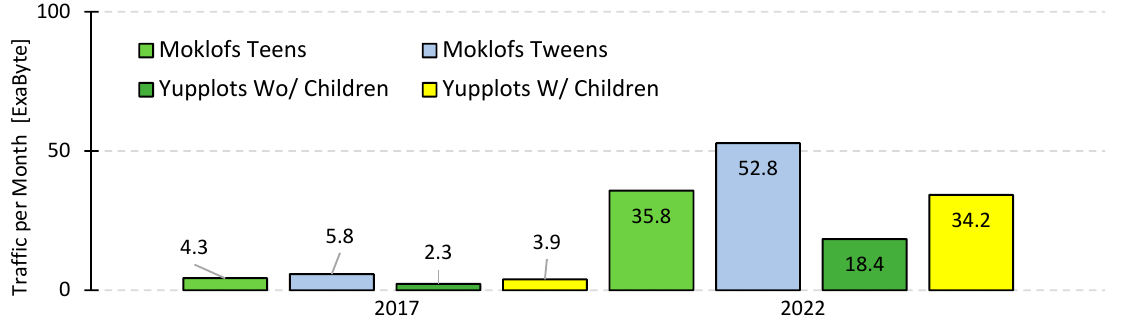
Figure 14. Tra ffi c per month 2017 versus 2022 for new Figure 14. Traffic per month 2017 versus 2022 for new clusters. Figure 14. Traffic per month 2017 versus 2022 for new clusters.